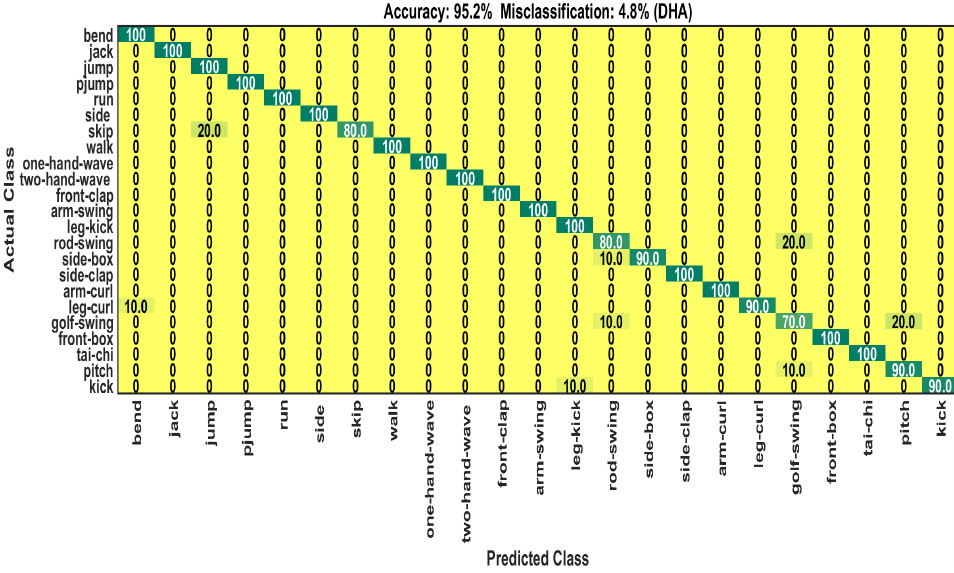
Figure 9. Confusion matrix on DHA test